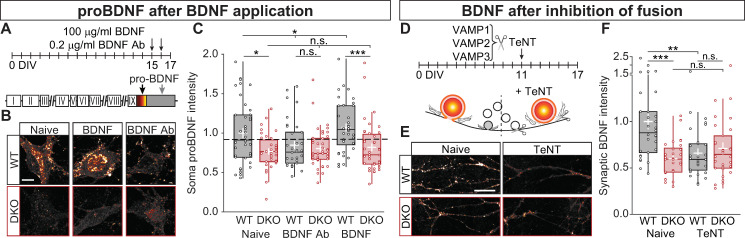
Secreted BDNF is sufficient to increase BDNF levels in the presence of CaMKII.(A) Schematic representation of the experimental design, 0.2 μg/ml of BDNF Ab or 100 ng/ml of recombinant BDNF were added every 24 hours for 2 days before fixing the neurons and immunostained for proBDNF. (B) Typical examples of proBDNF in the soma from untreated neurons (Naive), treated with BDNF Ab or BDNF. (C) Quantification of somatic proBDNF intensity normalized to WT (dash line). (D) Schematic representation of the experimental design, lentiviral particles containing TeNT, which is responsible to cleaved VAMP1-3 (hence, inhibiting SV and DCV fusion), were added 6 DIVs before fixing the neurons and immunostained for BDNF. (E) Typical examples of BDNF in synapses from untreated (Naive) cells or treated with TeNT. (F) Quantification of synaptic BDNF intensity normalized to WT (dash line). Boxplots with 95% CI whiskers, white cross shows mean ± SEM. Columns and dots represents individual litters and neurons, respectively. The presented data can be found in S1 Data. *p < 0.05, **p < 0.01, ***p < 0.001. Scale bar = 20 μm (B-E). BDNF, brain-derived neurotrophic factor; BDNF-Ab, BDNF antibody; CaMKII, Ca2+/calmodulin-dependent kinase II; CI, confidence interval; DCV, dense-core vesicle; DIV, day in vitro; DKO, double-knockout; SV, synaptic vesicle; TeNT, tetanus neurotoxin; VAMP, vesicle-associated membrane protein; WT, wild type.